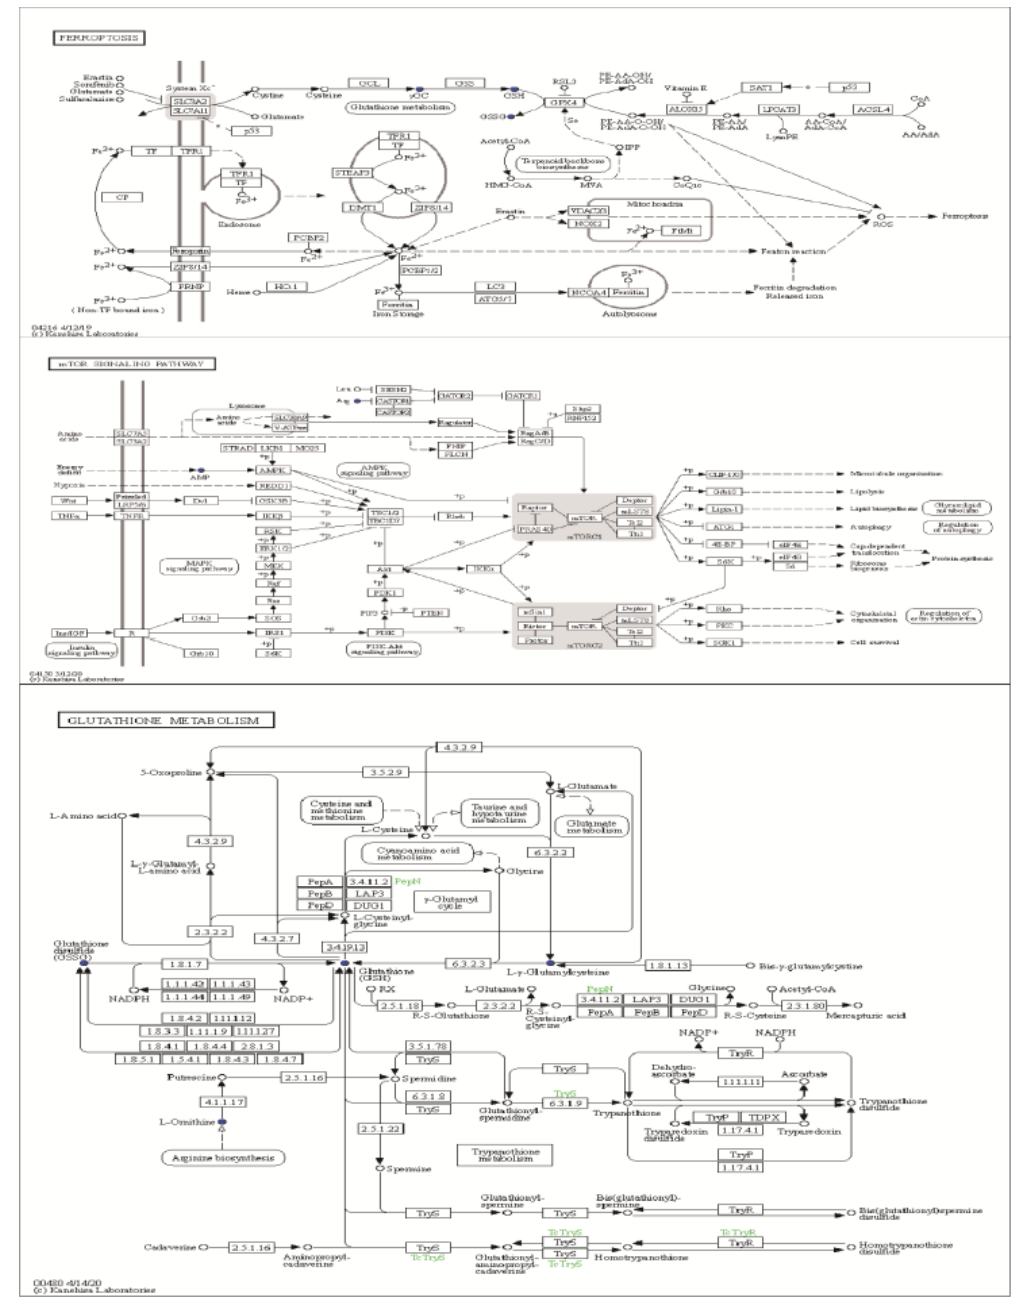
Figure 6. ( A ) KEGG analysis histogram of differentially expressed metabolites. Twenty metabolic pathways were identified based on the p -values. Impact values represent the contributions of metabolites detected for these pathways. The higher the impact value, the higher the contribution rate of the metabolites enriched in the pathway. ( B ) The results of untargeted metabolomics on ferroptosis, the mTOR signaling pathway, and glutathione between the CH2 group and the WLS group. Boxes represent protein molecules, and circles represent metabolic molecules. Red indicates the substance was upregulated, and blue indicates the substance was